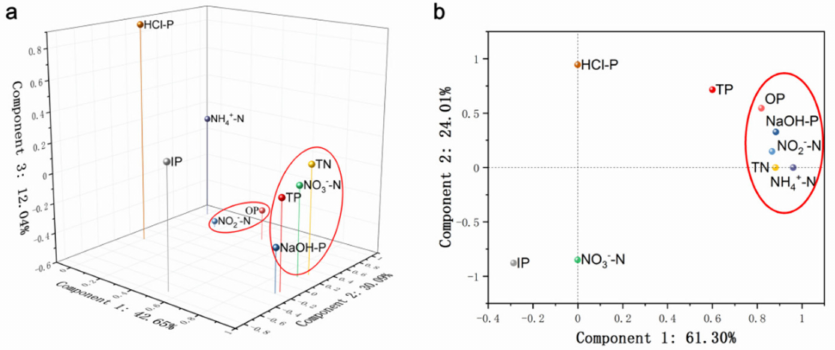
Figure 4. Principal score plots for nitrogen and phosphorus in sediments from the QCS Reservoir in flood seasons ( a ) and dry seasons ( b